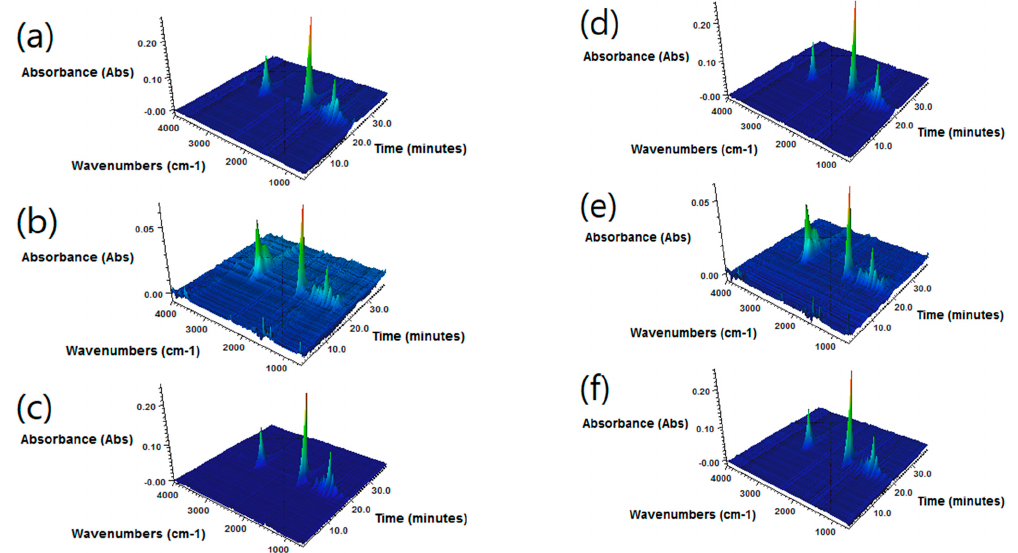
Figure 8. FTIR spectra of gaseous products evolved during thermogravimetric analysis ( a )